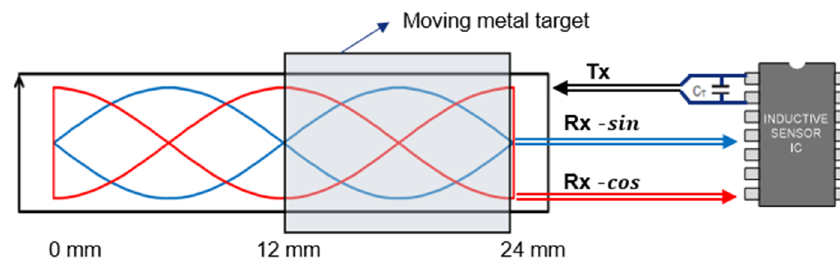
Figure 1. 3.5 MHz tuned excitation by integrated oscillator with pin capacitor